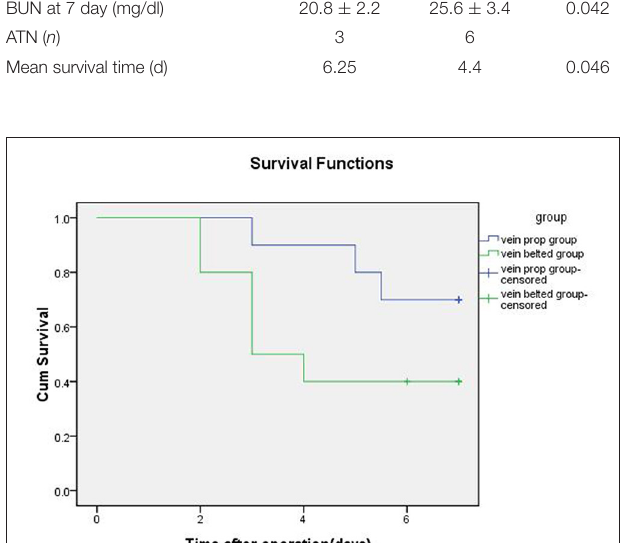
FIGURE 4 | Kaplan-Meier survival curve of the two groups receiving renal allografts.